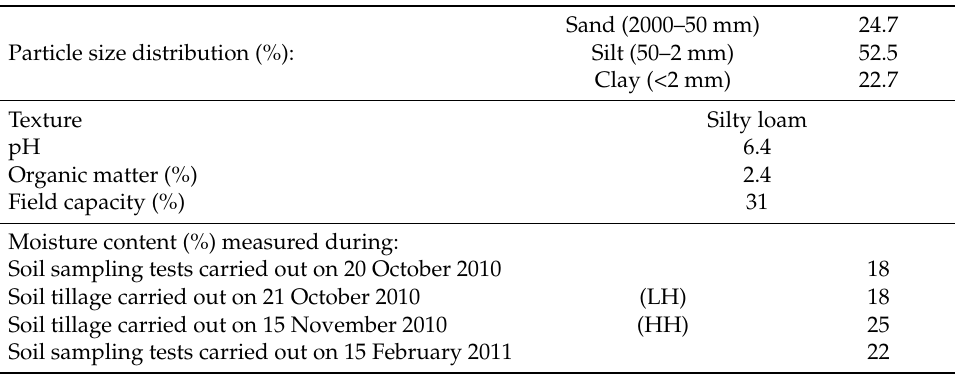
Table 1. Soil conditions during field tests (0–0.20 m